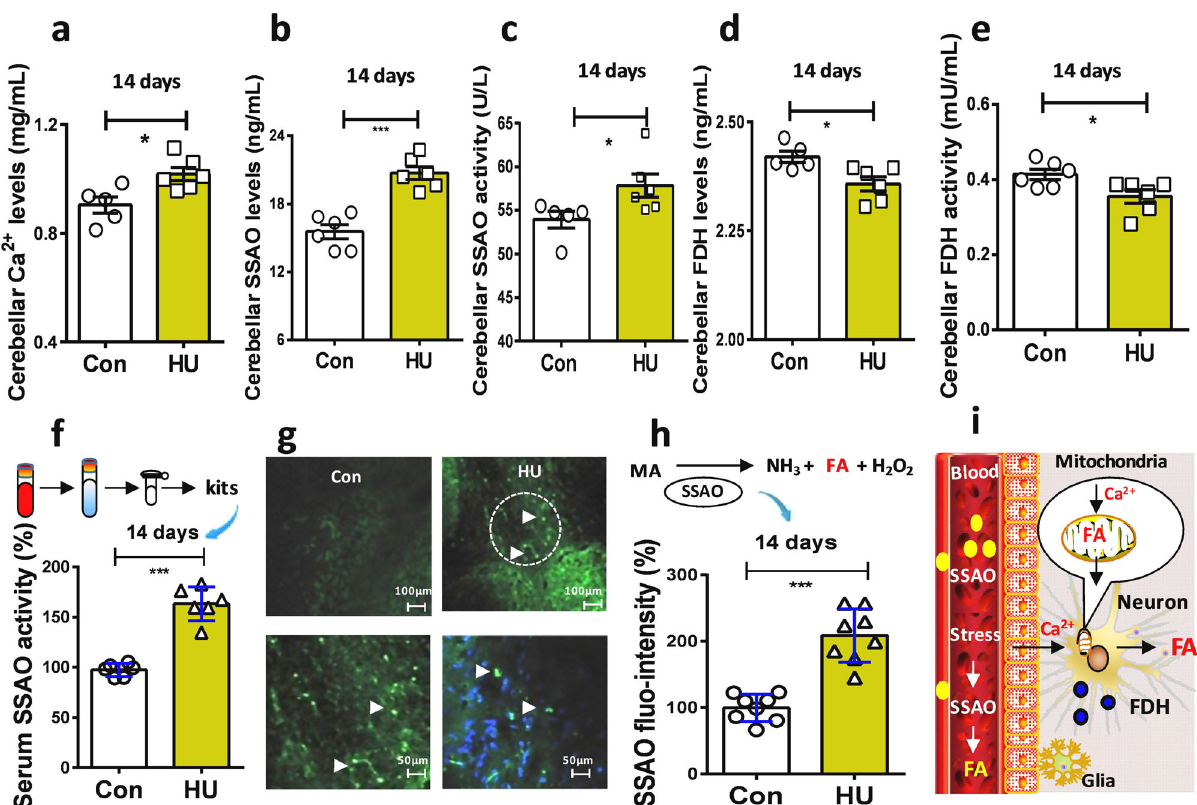
Fig. 2 Hindlimb unloading caused formaldehyde accumulation by affecting intracellular Ca2 + and FA metabolism in vivo. a HU-induced the elevation in brain Ca 2 + levels. ( n = 6). HU hindlimb unloading. b , c Changes in the contents and activities of SSAO in the cerebellum of HU mice. ( n = 6). SSAO semicarbazide-sensitive amine oxidase. d , e Changes in the contents and activities of brain FDH. ( n = 6). FDH formaldehyde dehydrogenase. f Blood SSAO activity detected using a mouse SSAO kit. ( n = 6). g SSAO (green) located in the cerebellum. DAPI (blue, a dye for nuclear). h Statistical analysis of cerebellar SSAO expression ( n = 8). i Model of stress-induced FA generation. FA formaldehyde, FDH formaldehyde dehydrogenase, SSAO semicarbazide- sensitive amine oxidase. Error bars show the mean ± SEM; * p < 0.05, *** p <